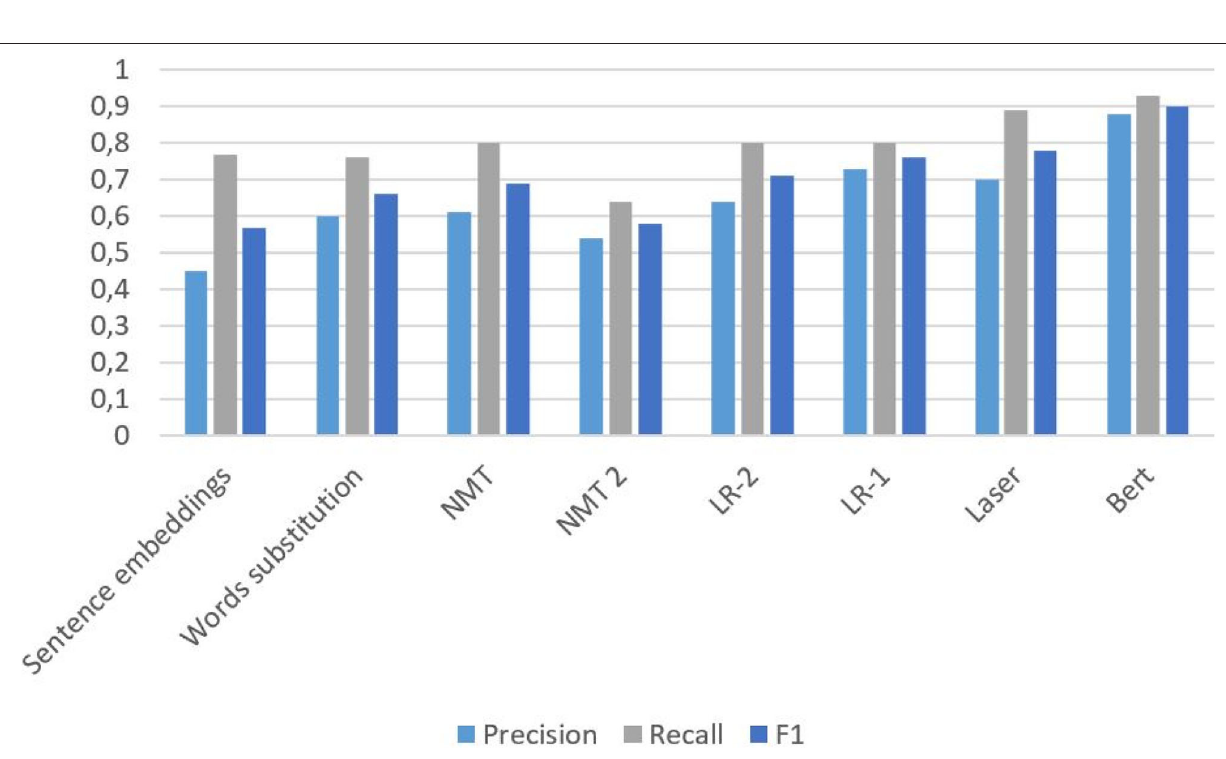
Frontiers in Computer Science |